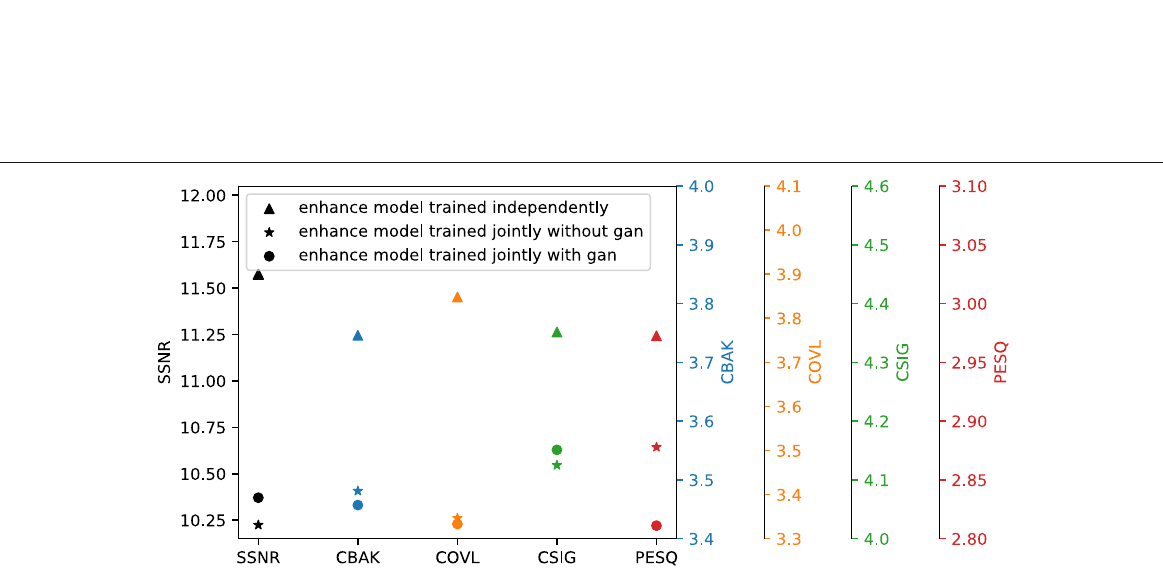
Fig. 7 The performance comparison of the enhancement model trained independently and the enhancement models trained jointly with Transformer ASR model without and with